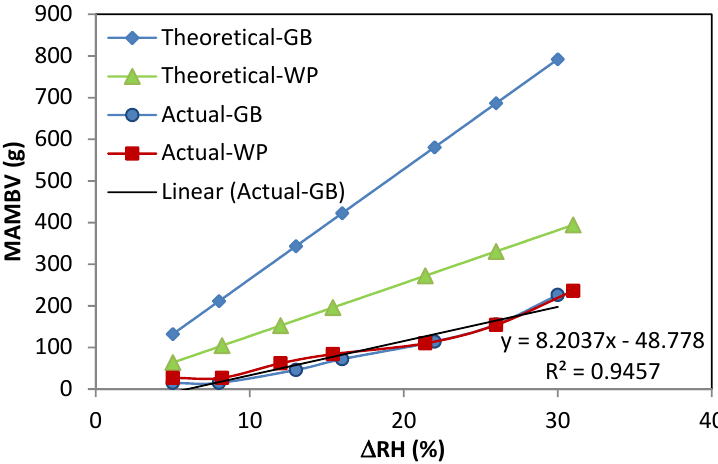
Figure 6. Relation between the MAMBV and the RH amplitude for both uncoated gypsum board and the wood paneling under ideal and realistic